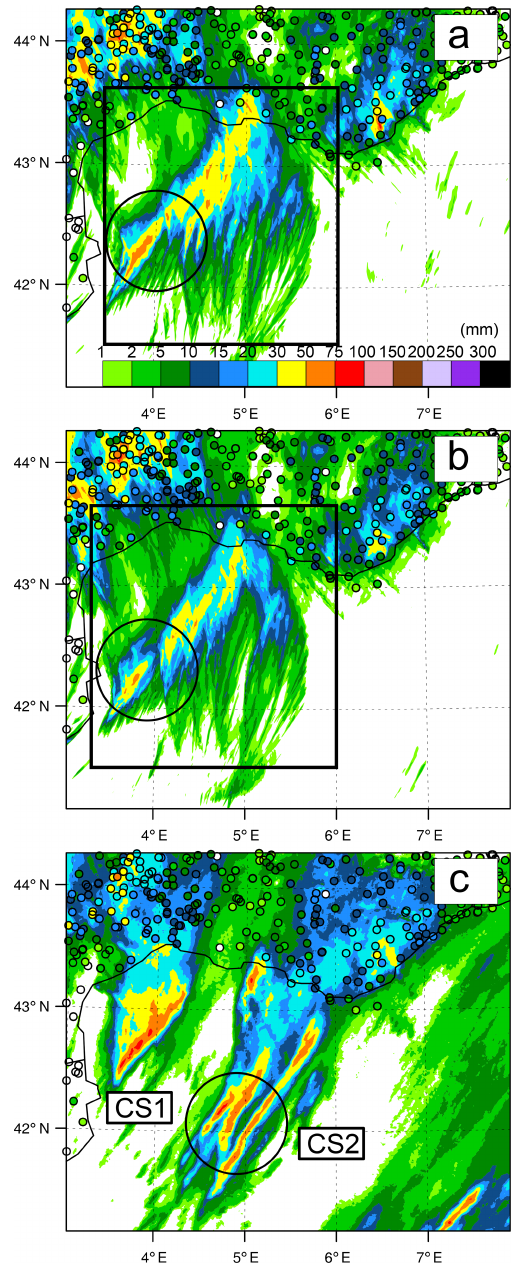
Figure 4. Six-hour accumulated simulated and observed surface precipitation from (a) the LR450 experiment, (b) the LR150 experi- ment, and (c) radar estimates between 06:00 and 12:00UTC on Oc- tober 2012. The small circles in the panels represent the rain gauge observations, whereas the largest ones highlight the surface precip- itation associated with CS2.